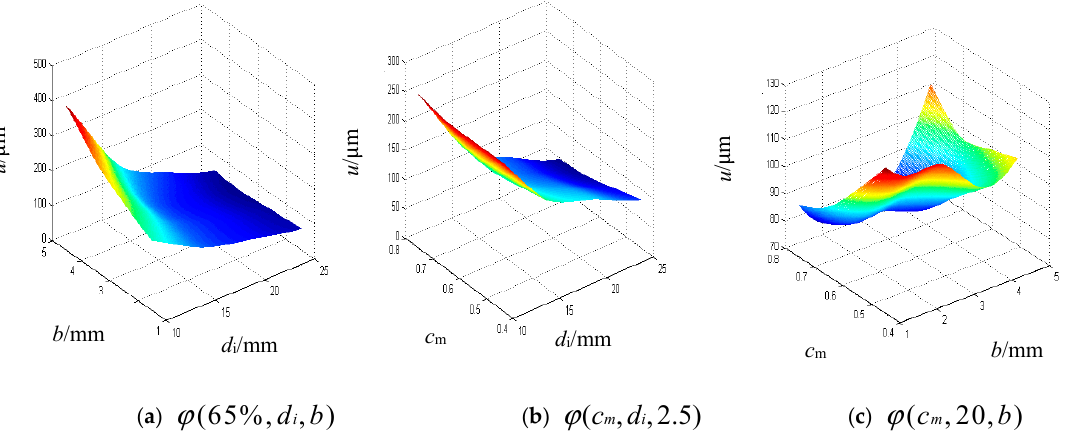
Figure 13. Response surfaces of the Kriging model.